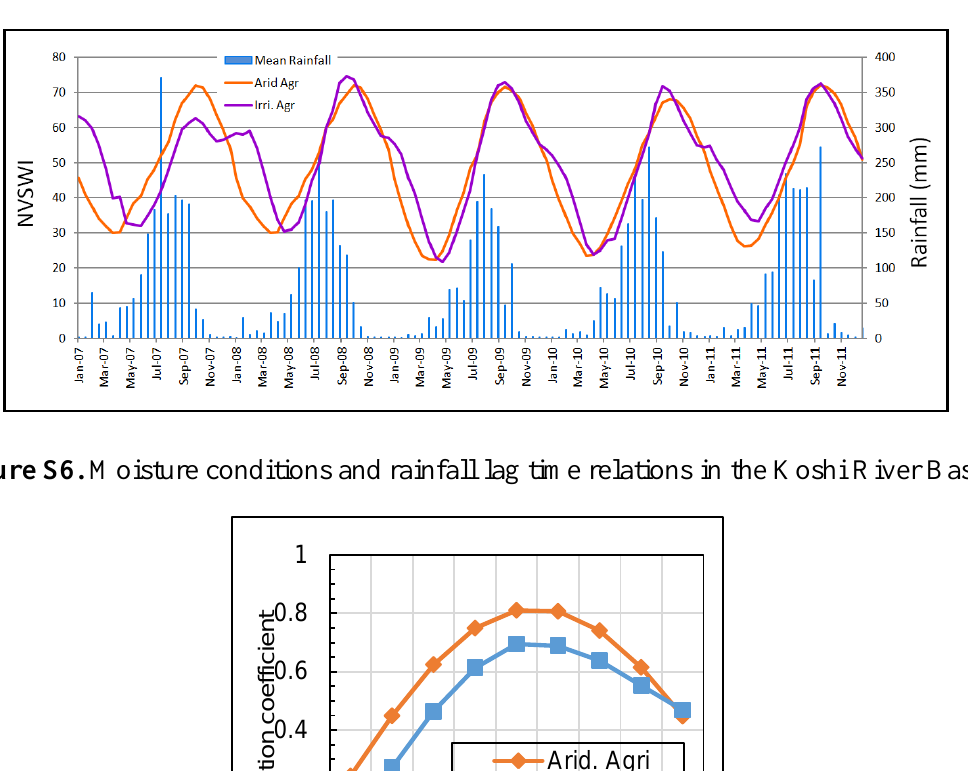
Figure S5 . Temporal patterns of moisture conditions in arid agriculture and irrigated agriculture area in the Koshi River Basin.